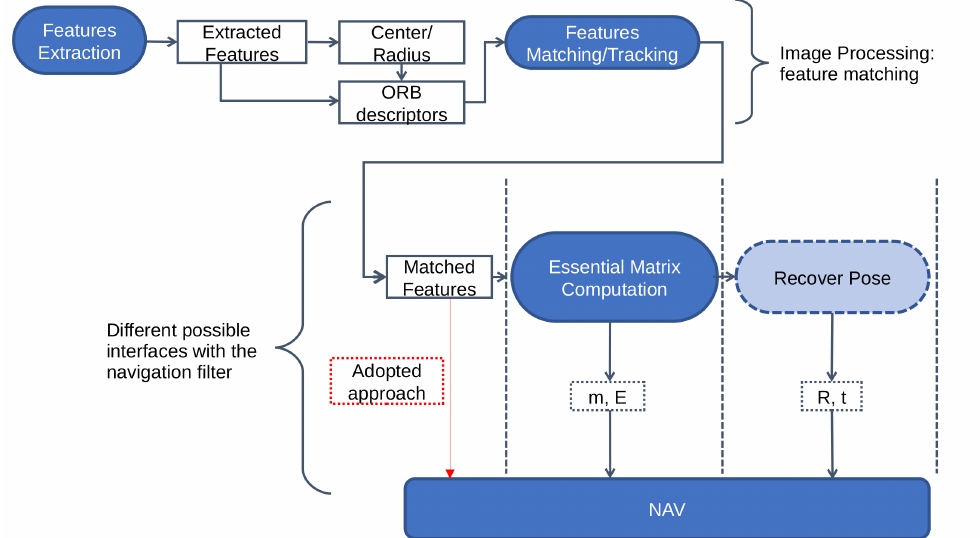
Figure 1. Schematics of the required pre-processing steps to interface with the navigation filter.